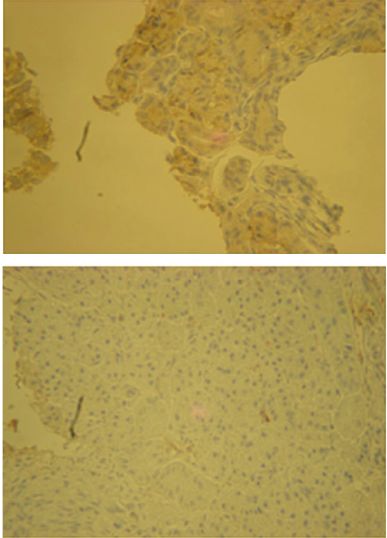
Figure 1 Immunohistochemical study for estrogen receptors befo- re (A) and after (B) hormone therapy